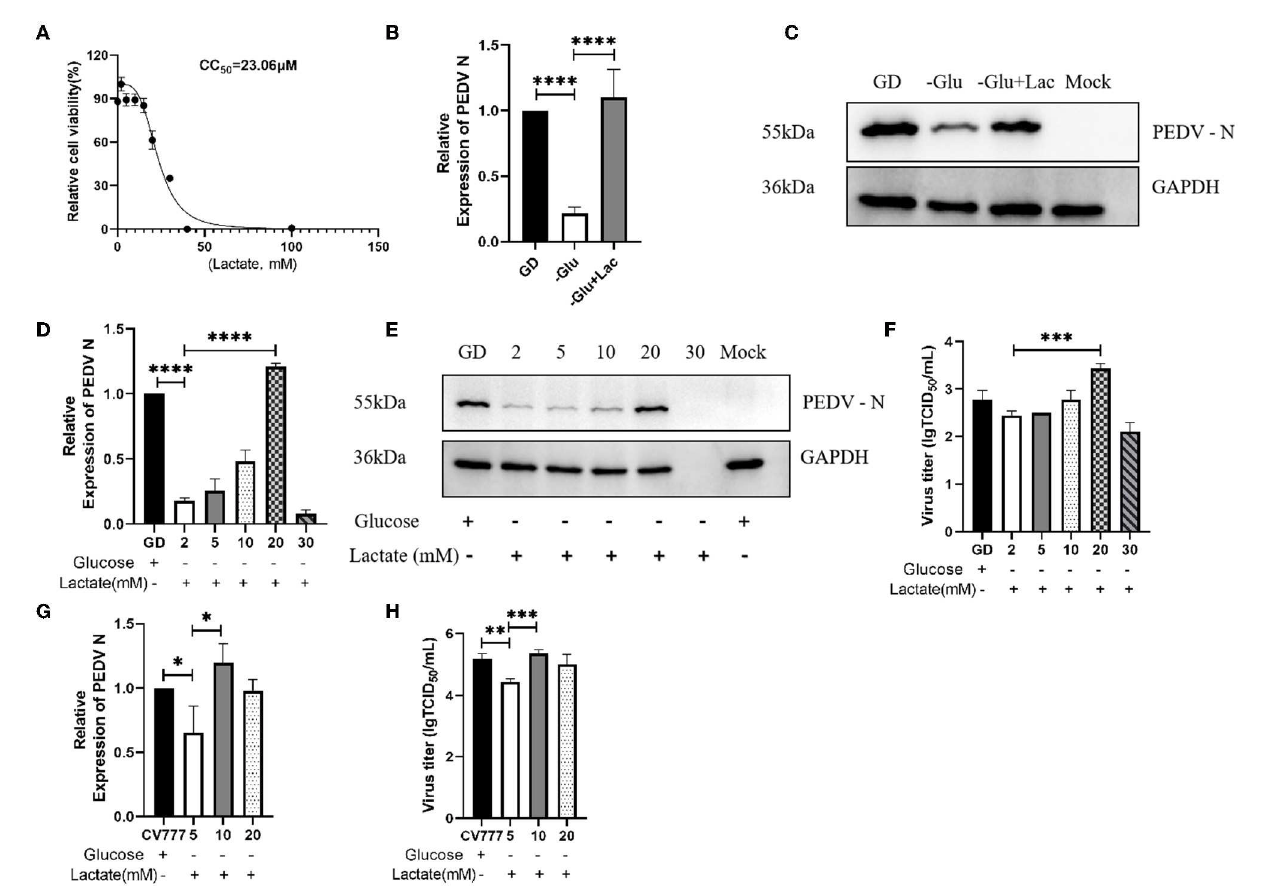
FIGURE2 Lactate is a key compound in the glycolytic pathway for the promotion of PEDV infection. (A) The CC 50 was calculated from the dose-response curves generated from the CCK-8 experimental data and subjected to nonlinear regression analysis. (B, C) Enhanced replication of PEDV GD/HZ/2016 (GD) strain was observed on supplementation of glucose-free DMEM with 20mM lactate (–Glu + Lac), as shown by the analysis of the PEDV N mRNA levels (B) and protein levels (C) at 24 hpi. (D–F) Replication of the PEDV GD/HZ/2016 strain was restored on supplementation of glucose-free DMEM with 5, 10, 20, and 30mM lactate, as shown by the analysis of the PEDV N mRNA levels (D) , protein levels (E), and viral titers (F) . (G, H) The analysis of the PEDV N mRNA levels (G) and viral titers (H) showed that the supplementation of 5, 10, and 20mM lactate in glucose-free DMEM restored the replicative capacity of the PEDV CV777 strain. The significance of * p < 0.05; ** p < 0.01; *** p < 0.001; **** p <